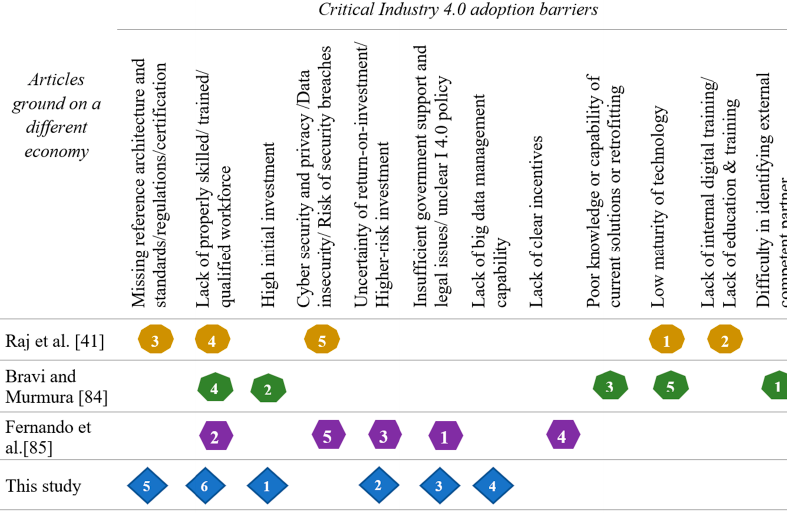
Figure 4. Mapping of critical adoption barriers.